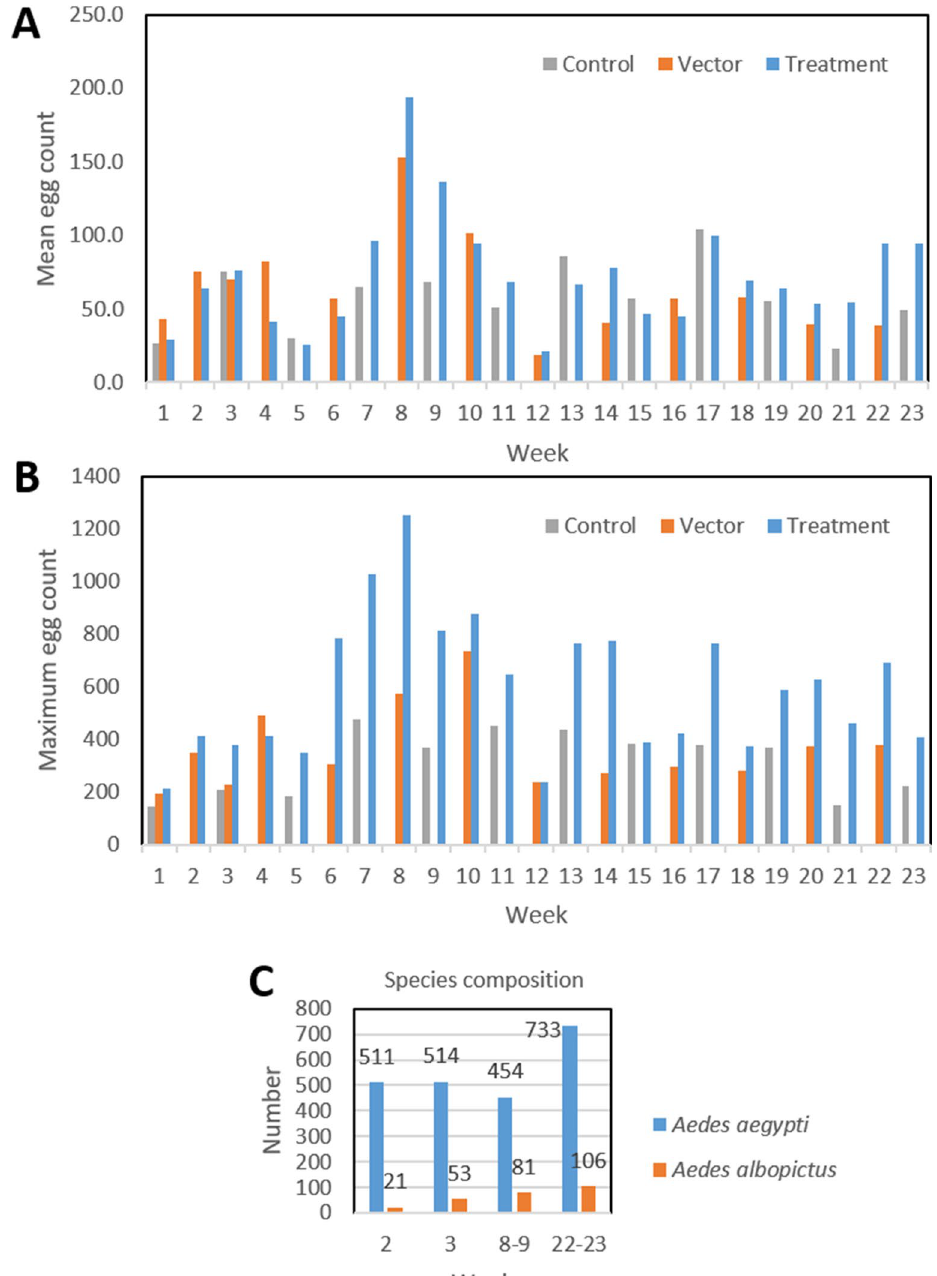
Figure 3. Summary of weekly egg collections of yeast-baited 10 L ovitraps positioned across Control, Vector, and Treatment blocks. ( A ) Mean egg counts; ( B ) Maximum egg counts; ( C ) A. aegypti vs. A. albopictus composition from eggs reared from select weekly